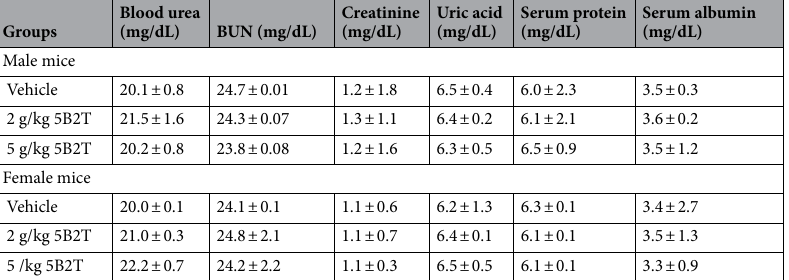
Table 1. Renal function test of experimental mice treated with high doses of 5B2T. Values expressed as mean ± S.E.M. There are no significant differences between groups. Significant value at p < 0.05.